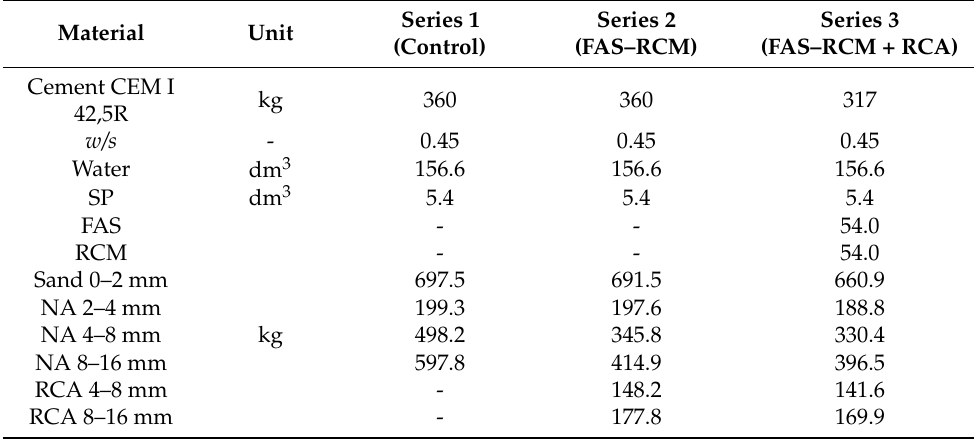
Table 7. The test plan and concrete mix compositions per 1 m 3